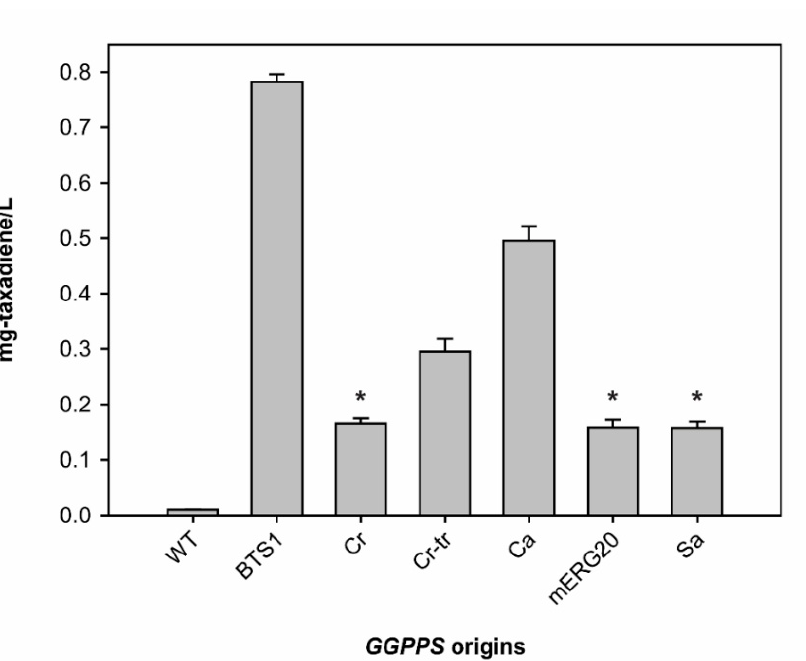
Figure 3. Taxadiene production titer using S. cerevisiae transformed with Tm-TS and pIPP with overexpression of different geranylgeranyl pyrophosphate synthases ( GGPPSs ) from various species. The asterisks indicate no significant differences between the data ( p value > 0.05). The bars without asterisk have significant different between them ( p value < 0.01). Abbreviations: WT, Saccharomyces cerevisiae strain BY4742 without overexpression of GGPPS ; BTS1, Saccharomyces cerevisiae GGPPS ; Cr, Chlamydomonas reinhardtii GGPPS ; Cr-tr, truncated Cr; Ca, Capsicum annuum GGPPS ; mERG20, mutant of yeast FPPS ; Sa, Sulfolobus acidocaldarius GGPPS .